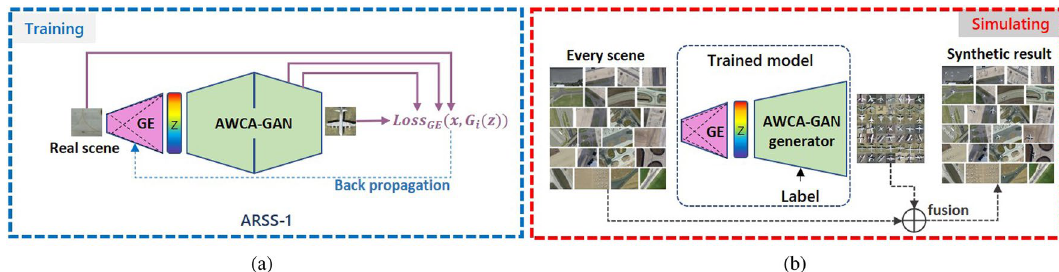
Figure 1. Overall workflow of our ATSS-1. ( a ) Two sub-networks in ATSS-1 and the training process. ( b ) Diagram of simulating process. When performing a simulating task, each sample is put into the trained ATSS-1 to generate the required images and then applying the post-processing step of Poisson blending 31 to synthesise the final RS images.